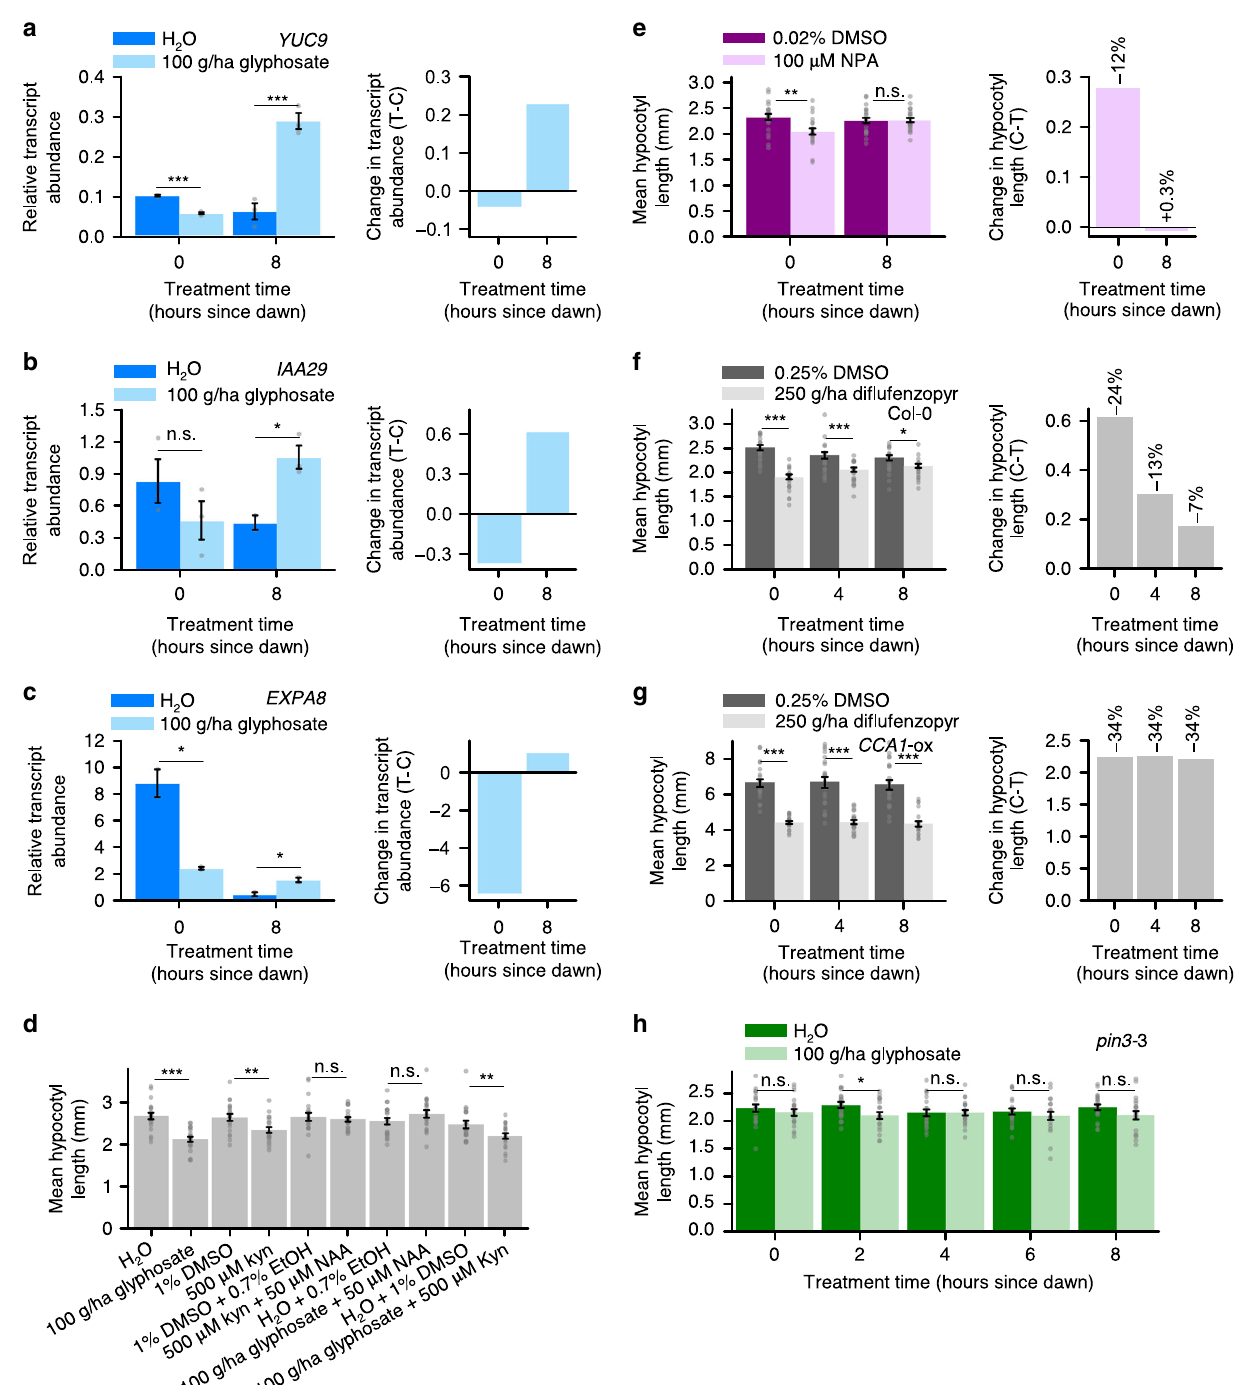
Fig. 3 Processes associated with auxin signalling might underlie rhythmic sensitivity of hypocotyl length to glyphosate. a – c 100 g/ha glyphosate-induced alterations in auxin signalling transcript abundance depends on treatment time. Graphs show (left) relative transcript abundance and (right) change in transcript abundance caused by glyphosate. Reference transcript was PP2AA3 . d Mean hypocotyl length of seedlings treated with either glyphosate, kynurenine (kyn), kyn + NAA, glyphosate + NAA, or glyphosate + kyn at dawn. e Mean hypocotyl lengths of seedlings treated with NPA or DMSO vehicle control at dawn or dusk. f, g Attenuation of hypocotyl length by 250 g/ha di fl ufenzopyr or DMSO vehicle control applied at 4 h intervals, in f Col-0 and g CCA1 -ox seedlings under 8 h photoperiods. Chemical treatments were on day 3 and measurements on day 7. g Mean hypocotyl length of pin3 -3 seedlings treated with 100 g/ha glyphosate at 2 h intervals throughout the photoperiod. Signi fi cance determined by a – c ; e – h two-way ANOVA and t -test comparisons and d t -tests. n.s. = not statistically signi fi cant, * P ≤ 0.05, ** P ≤ 0.01, *** P ≤ 0.001. Data are mean ± s.e.m: n = 2 – 3 (transcript analysis); n = 20 (hypocotyl measurements). Transcript abundance change expressed as treated (T) – control ( c ). Source data are provided in the Source Data fi